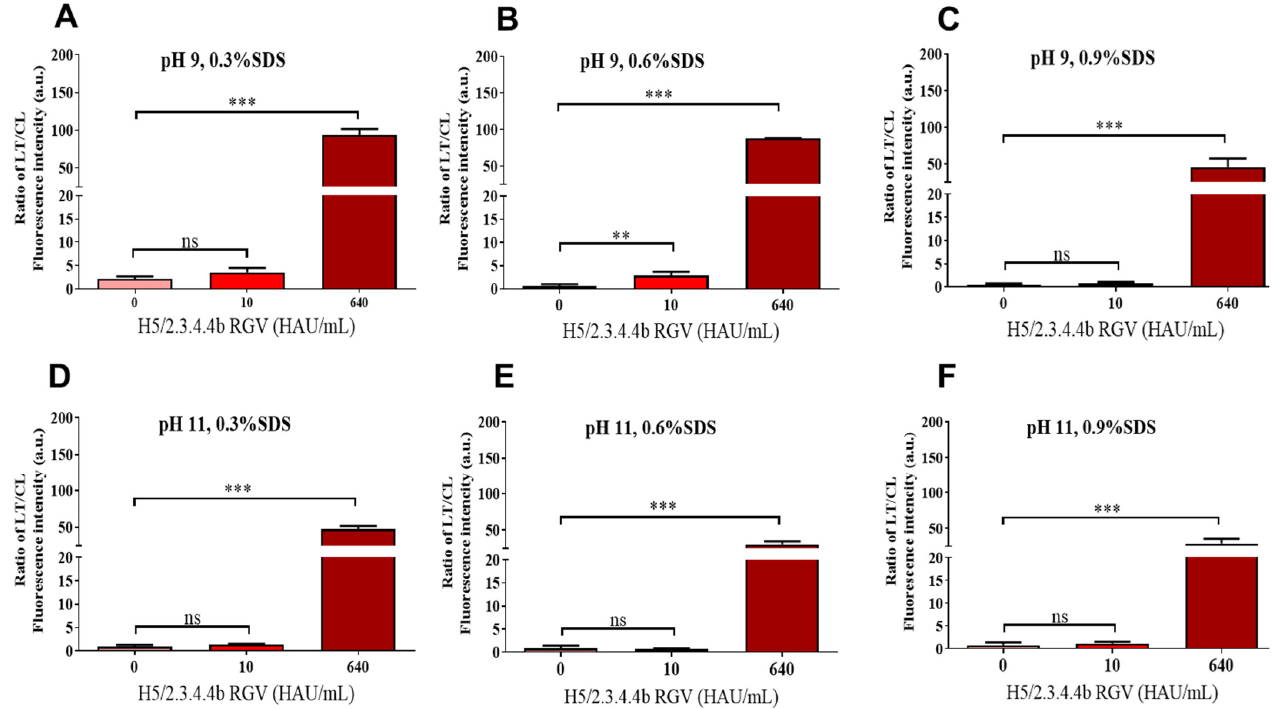
Figure 5. Optimization of lysis buffer for FICT of the Eu bio-conjugate #11-4 and #23.3 strip coating. Various concentrations of SDS (0.3, 0.6, and 0.9%) at pH 6.0 (Figure S6), 9.0 ( A – C ), and 11.0 ( D – F ) were tested in basic lysis buffer (0.1 M Tris, 0.1 M EDTA, and 0.5% Triton X-100). One-way ANOVA was used to analyze the FICT data. ** p < 0.01; *** p < 0.001; ns, not significant. Raw fluorescence peaks from the test line (TL) and control line (CL) in FICT are shown in Supplementary Figure S6.